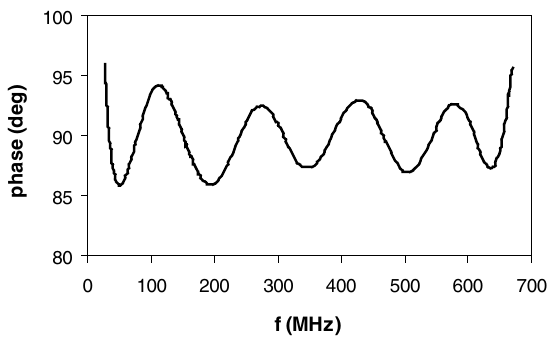
FIG. 20. Phase analysis of the 90 (cid:3) phase shifter used for the RR.